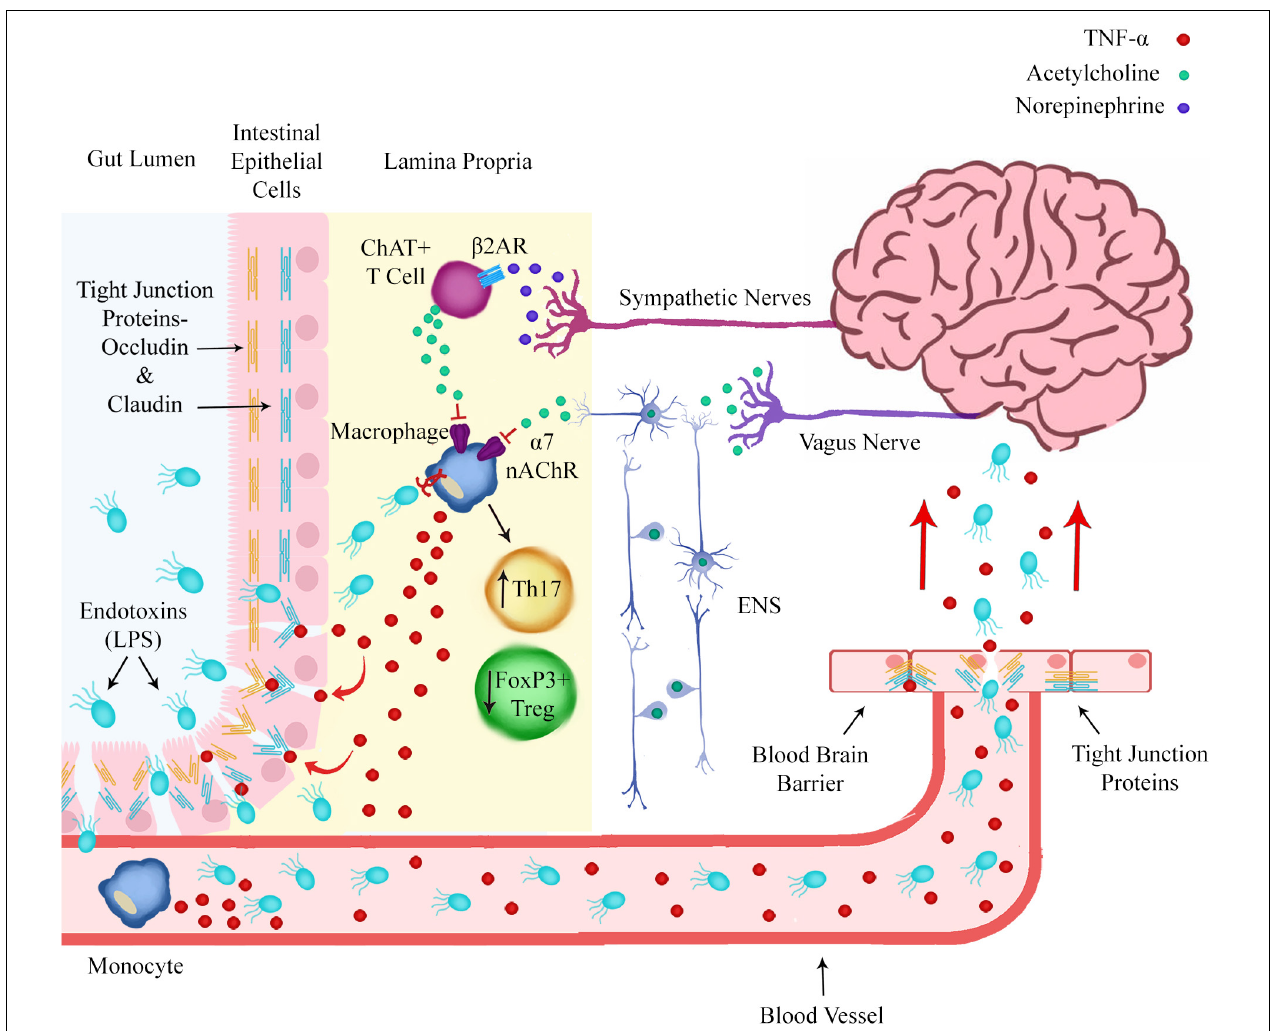
FIGURE 2 | Norepinephrine and acetylcholine release from sympathetic nerves and the enteric nervous system (ENS) in the intestinal wall regulates pro-inflammatory polarization of immune cells. Prolonged macrophage production of pro-inflammatory cytokines such as TNF- α could lead to degradation of the intestinal epithelial barrier and blood brain barrier by modulating the expression of tight junction proteins. This would allow endotoxins such as LPS to translocate from the gut lumen to the brain via the circulatory